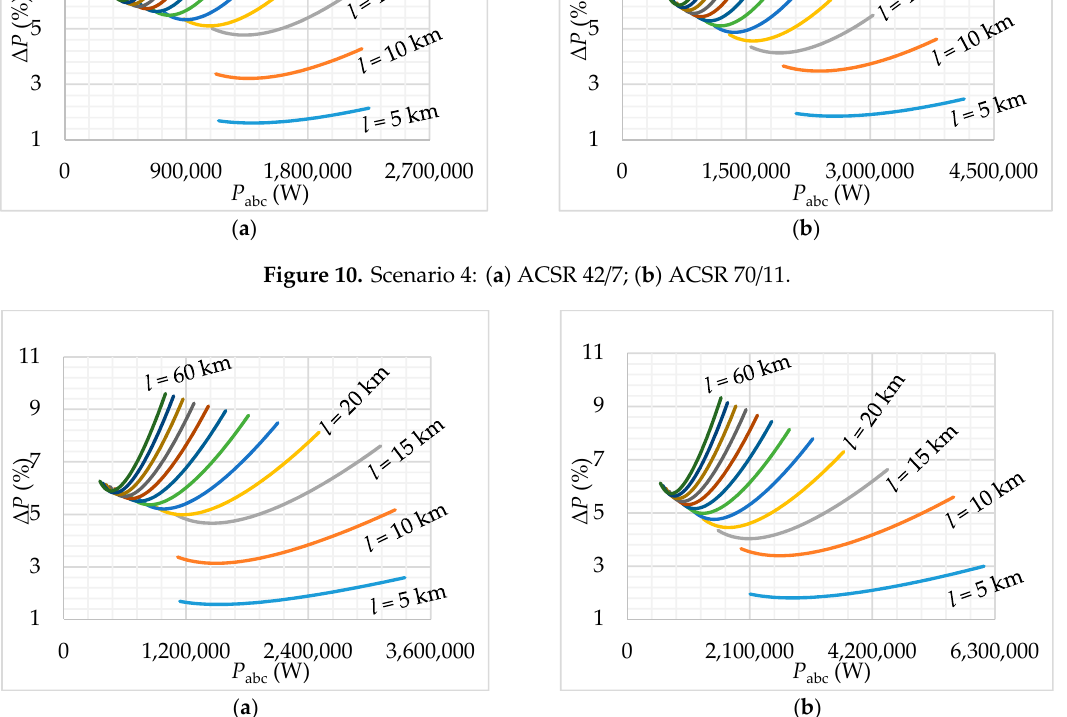
Figure 11. Scenario 5: ( a ) ACSR 42/7; ( b ) ACSR 70/11.